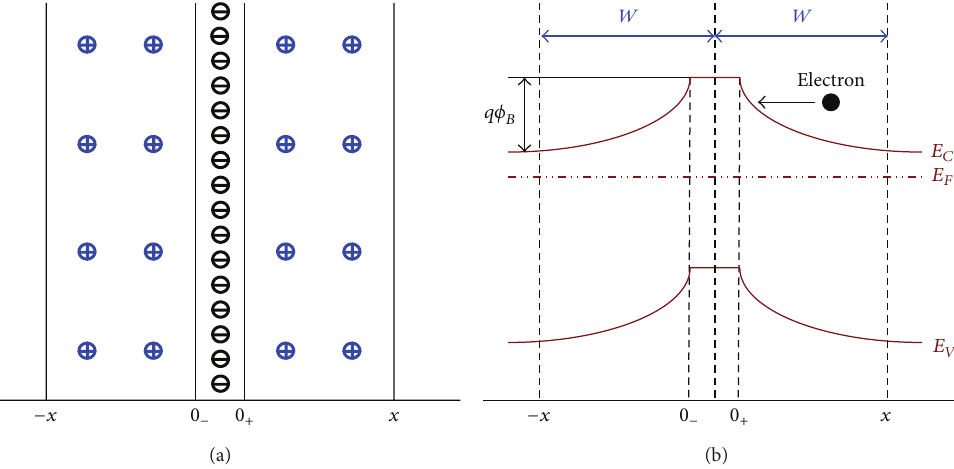
Figure 29: (a) The charge distribution of an electron trapping grain boundary and (b) the resulting potential energy barrier at the grain boundary. 𝑞𝜙 𝐵 is the potential barrier and 𝑊 is the depletion